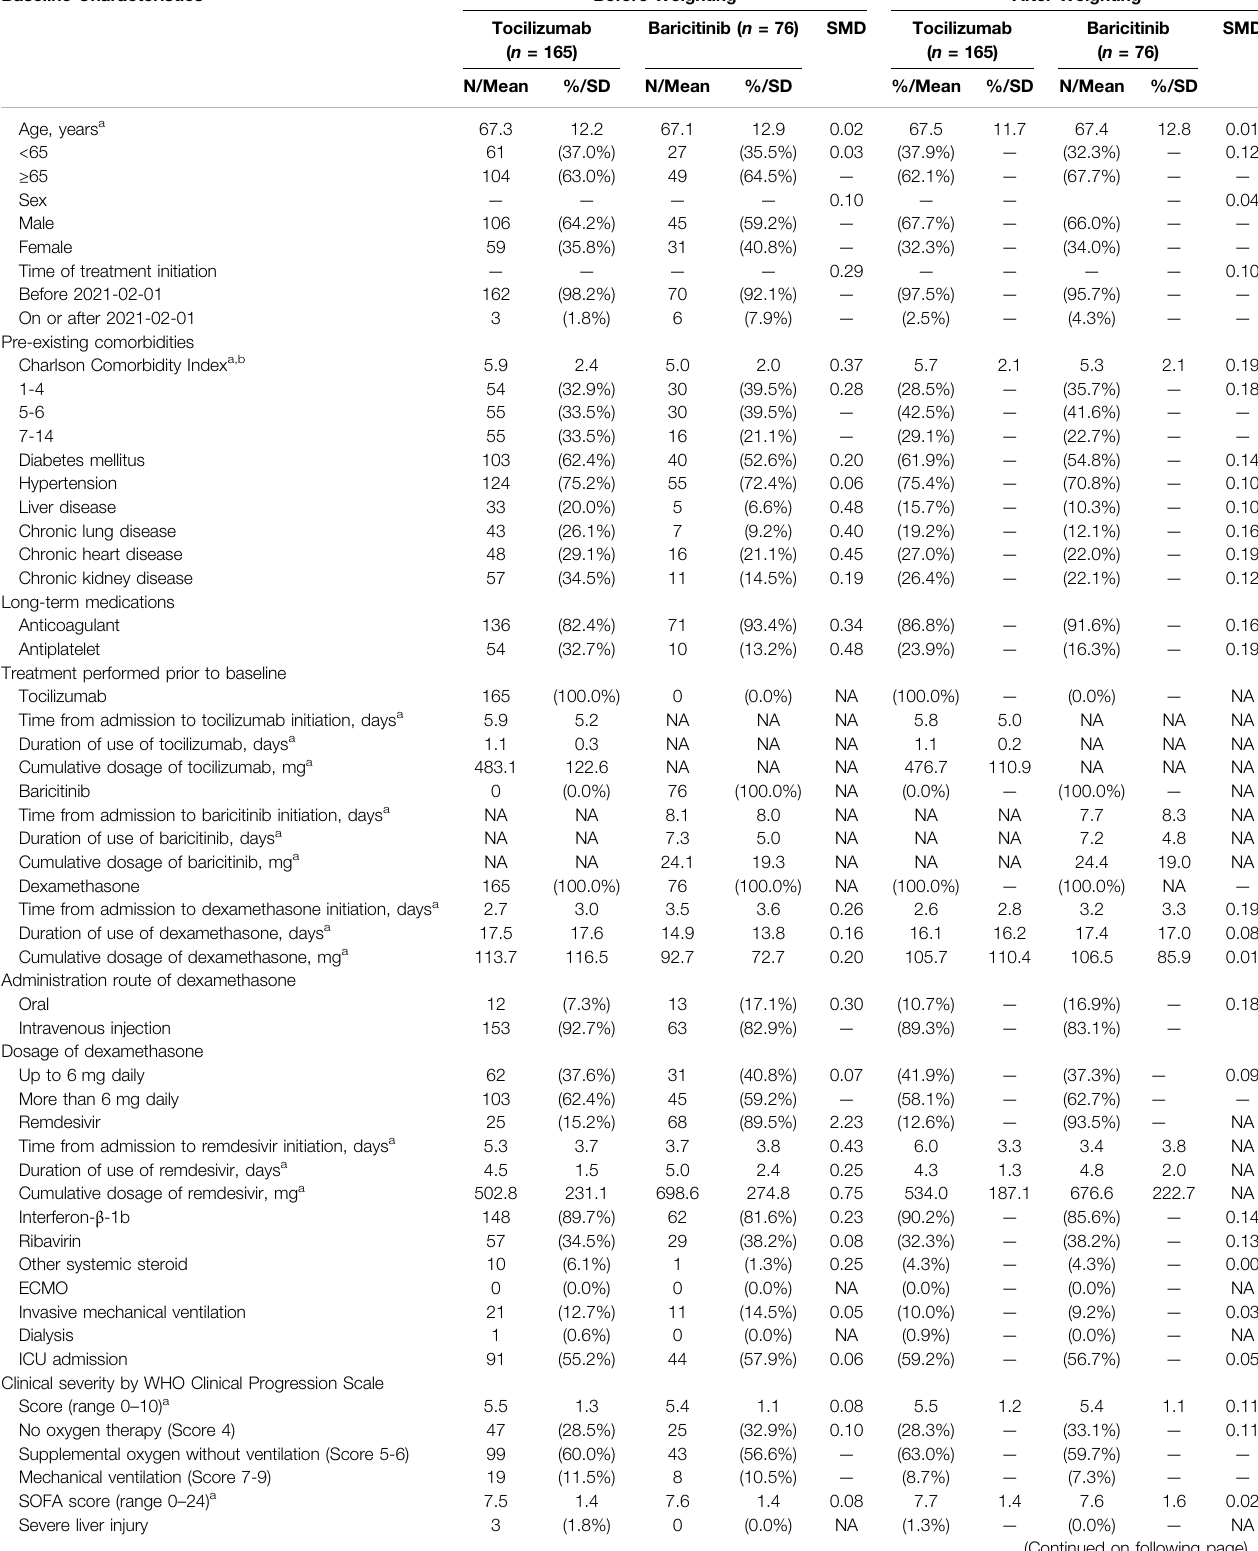
TABLE 1 | Baseline characteristics of hospitalized patients with COVID-19 in tocilizumab and baricitinib groups after multiple imputation and propensity score weighting. Baseline Characteristics